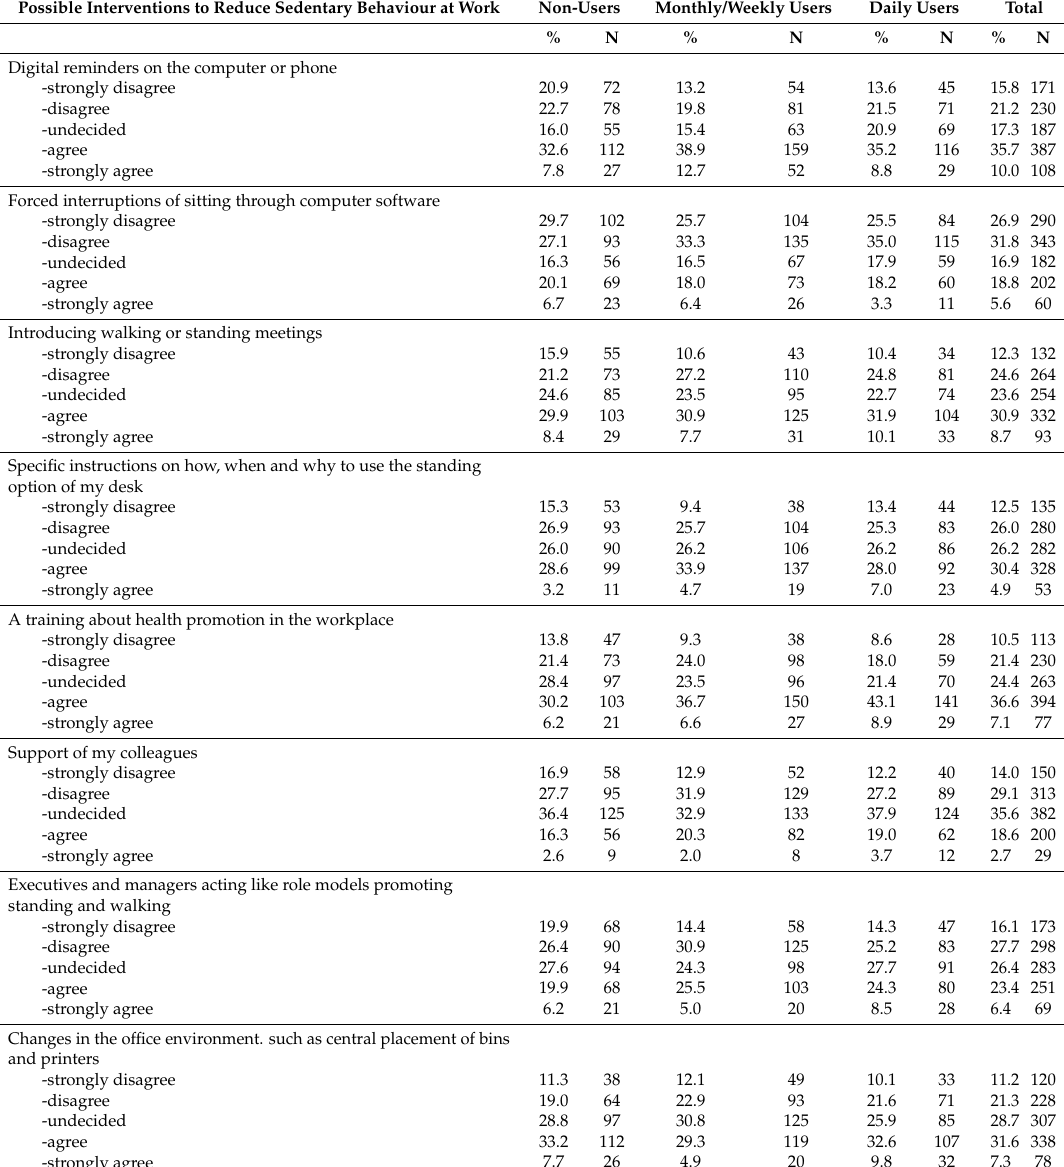
Table A7. Agreement with feasibility of potential interventions to reduce sitting time at work per user group.